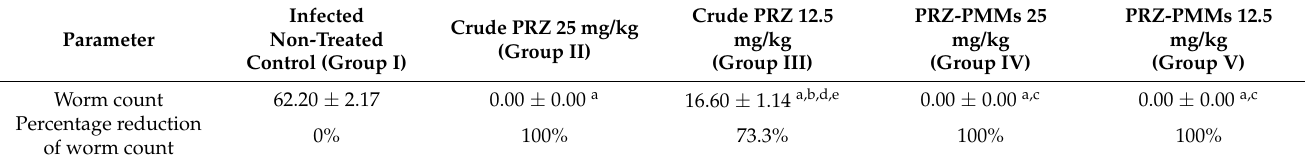
Table 8. Worm burden and its percentage reduction among the different